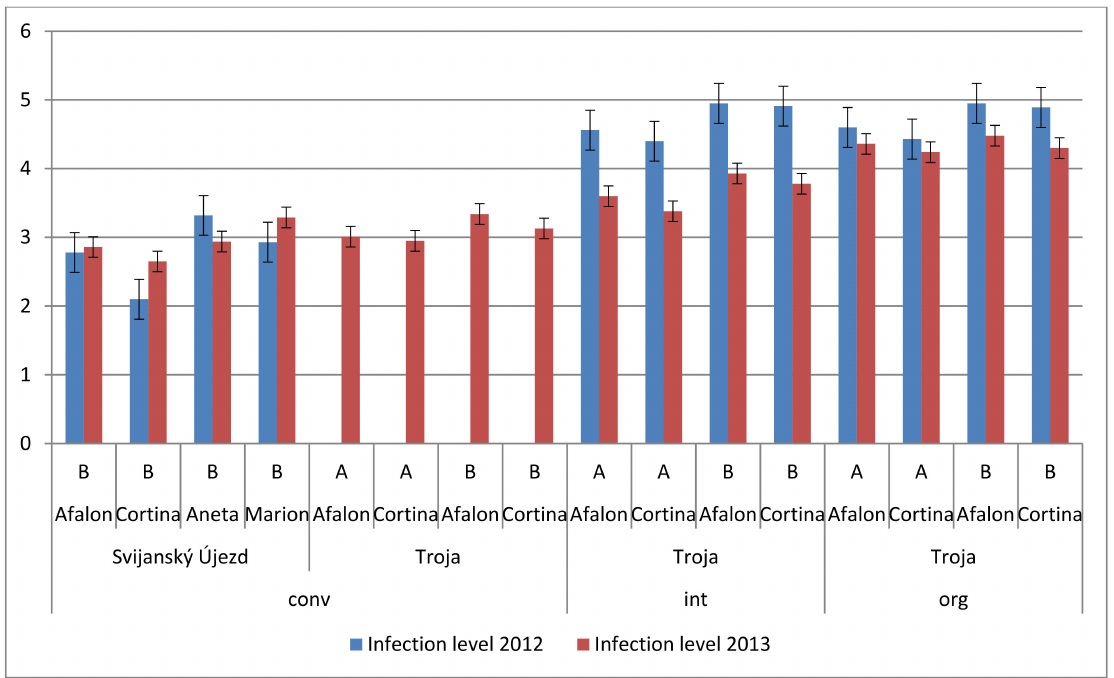
Figure 6. Effect of seeding density and production system on the levels of spontaneous infection of Cortina and Afalon at the Troja locality in 2012 and 2013. Seeding density: A, 6 × 10 5 seeds ha − 1 ; B, 9 × 10 5 seeds ha − 1 ; the level of spontaneous infection is expressed in arbitrary